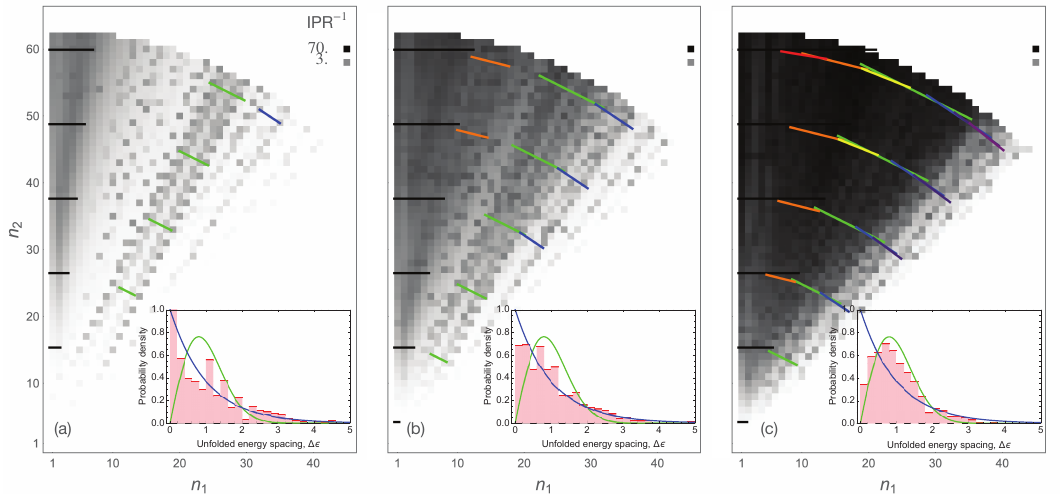
(cid:80) |〈 λ | n 〉| 4 ) − 1 (i.e. the inverse of the , n λ 1 2 ) 〉 of two one-dimensional , n 1 2 − M ) / ( M + M ) . The values of ε are 2 1 2 1 ) = 0.5. The insert shows max min ¯ n 2 with 37.1 < ¯ n < 52.0, in 0